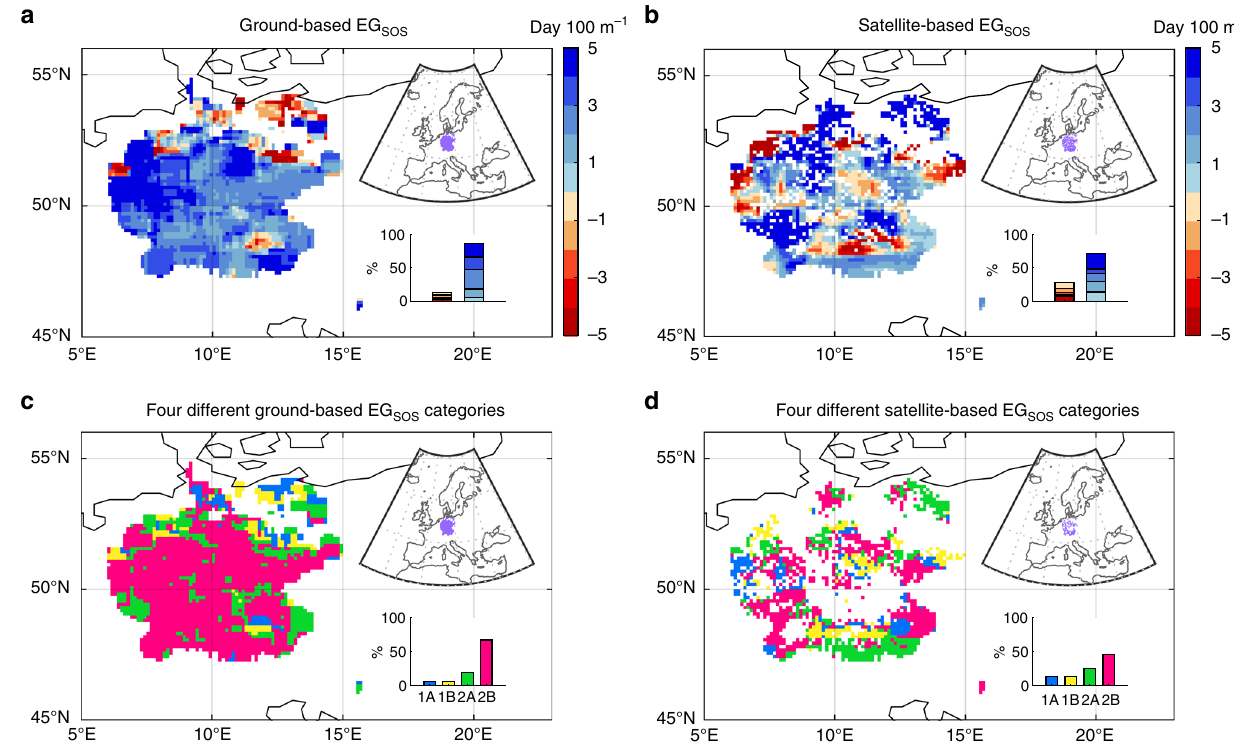
Fig. 5 Spatial patterns of the elevational gradient of SOS (EG SOS ) and their temporal trends. a The spatial pattern of ground-based EG SOS from 1982 to 2011. b The spatial pattern of satellite-based EG SOS from 1982 to 2011. Frequency distribution of the EG SOS values is shown in the inset at the bottom-right for each panel. c The spatial pattern of different categories of the temporal trends in ground-based EG SOS during 1982 – 2011. d The spatial pattern of different categories of the temporal trends in satellite-based EG SOS during 1982 – 2011. The area fraction of each of the four different categories in the temporal trends of EG SOS is shown in the inset at bottom-right for each panel. The location of the regions with European phenology stations is shown in the inset at top-right for each